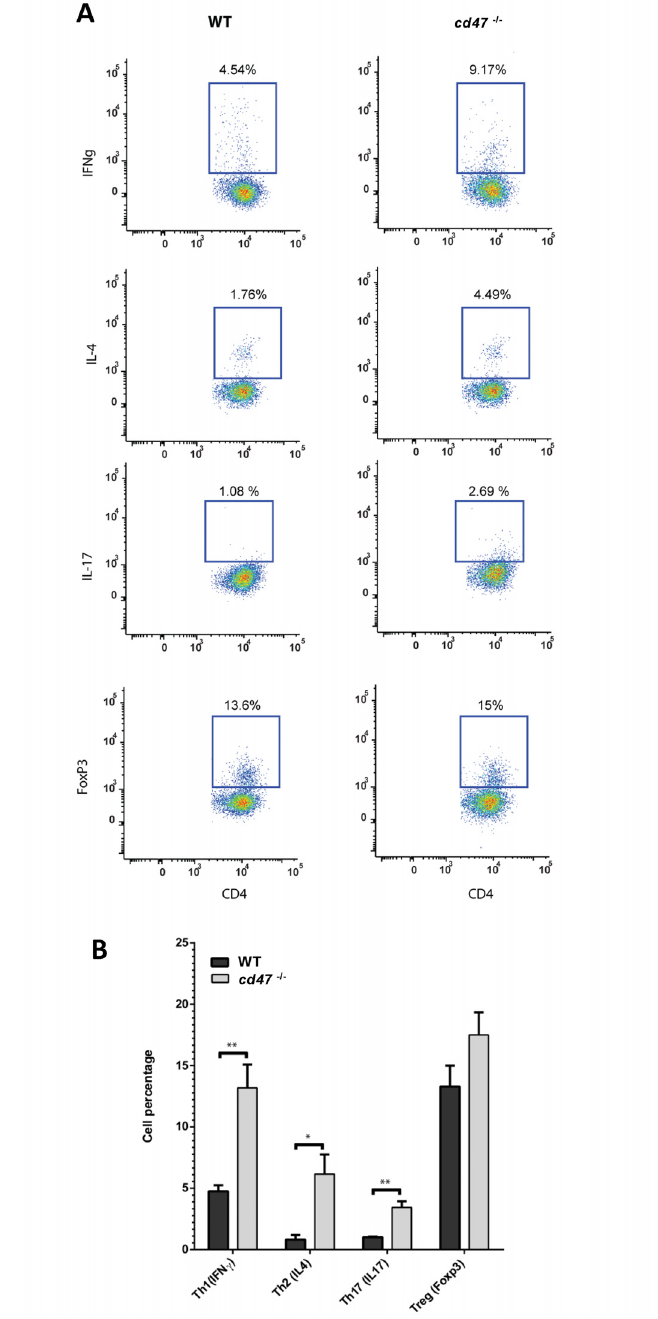
Fig 6. Th subset expansion in spleens of cd47 -/- and WT mice infected with C . albicans . Intracellular flow cytometry was performed on splenocytes at day 7 PI. Splenocytes were stimulated with PMA/ionomycin, and cytokine profiles were measured by five color multi-parameter flow cytometry. (A) Representative flow plots of CD4+ T cells from spleens of C . albicans infected WT vs cd47 -/- mice analyzed for intracellular IFN γ , IL-4, Il-17 and Foxp3 expression. Uninfected WT and cd47 -/- mice showed no difference in expression (data not shown). (B) Cumulative bar graph presenting the percentages of Th1 (IFN γ +), Th2 (IL-4+), Th17 (IL-17+), and Treg (Foxp3+) CD4+ T cells in infected WT and cd47 -/- mice. Results from 5 mice per group were analyzed using two-way ANOVA with post Bonferroni comparison